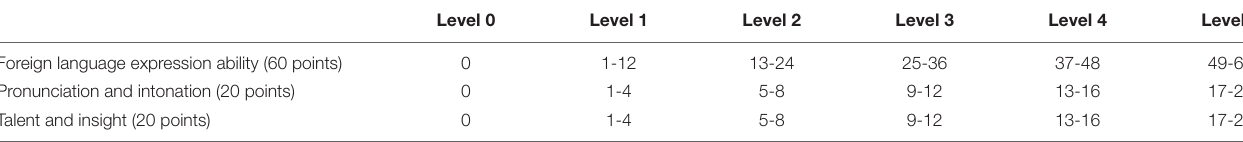
TABLE 3 | Grading criteria.